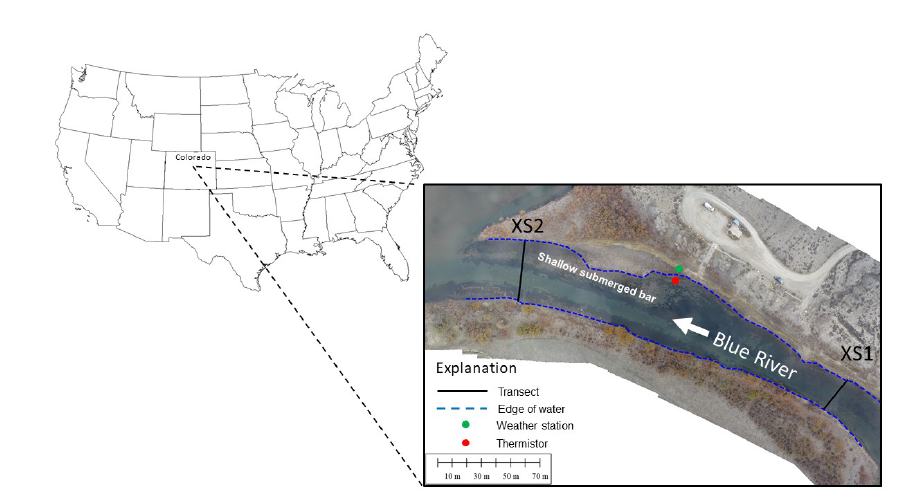
Figure 1. Location of study area and the two cross sections on the Blue River where discharge calculations were made. The edge of water, a shallow submerged bar, and the positions of the weather station and thermistor are also